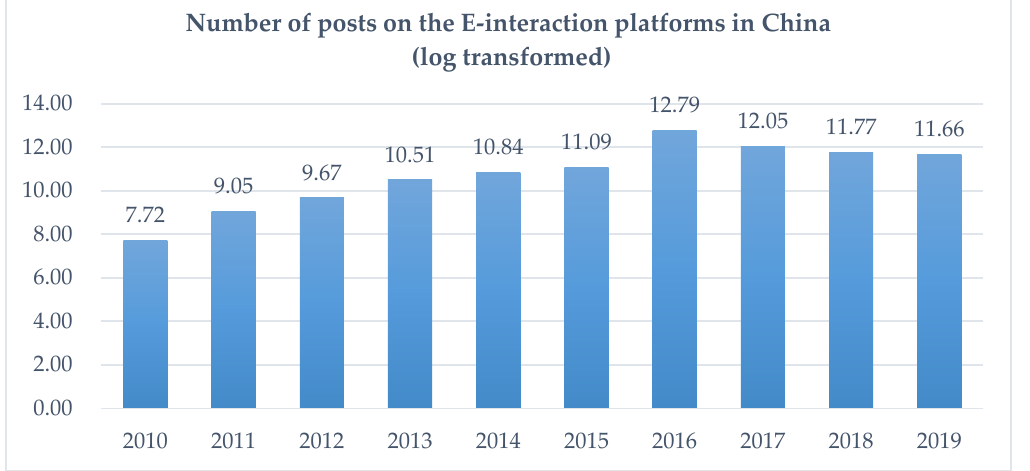
Figure 1. Trends in the volume of posts on the E-interaction platforms (log-transformed) in China.